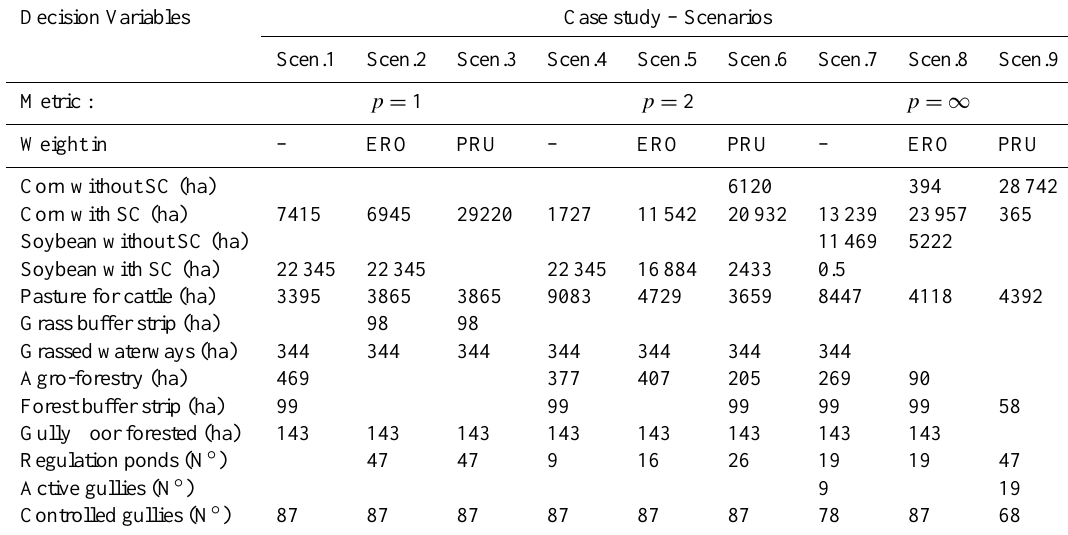
Table 5. Results from CP of nine scenarios for the DV in La Colacha. Decision Variables